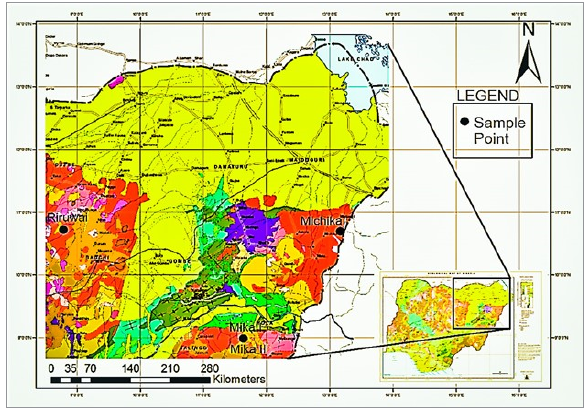
Figure 1: Map of Nigeria showing the uranium mining sites where samples for this work were collected.